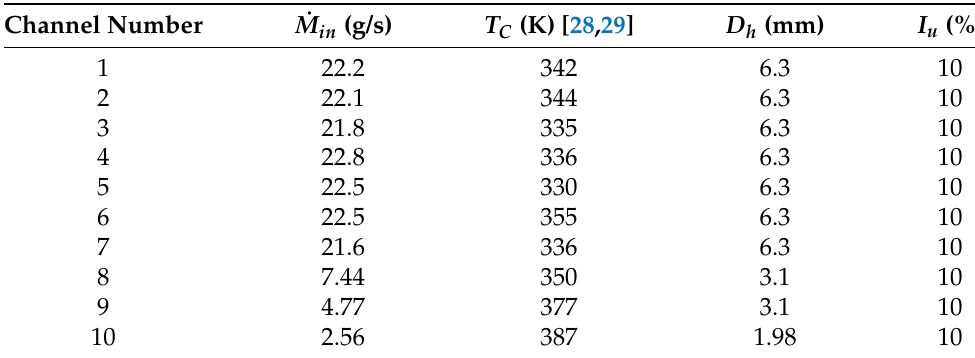
Table 4. Boundary conditions of the cooling